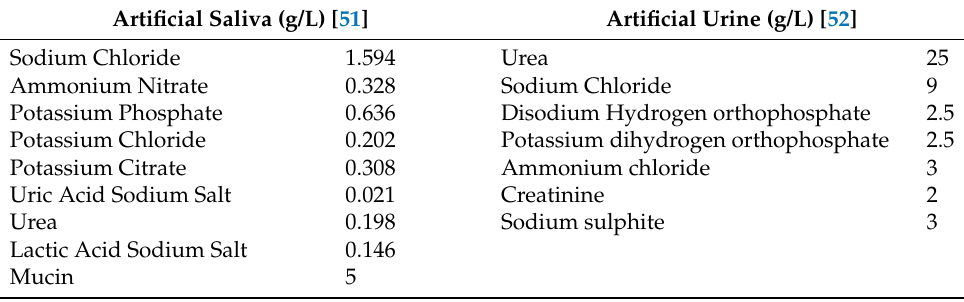
Table 2. Chemical composition of commercial artificial urine and